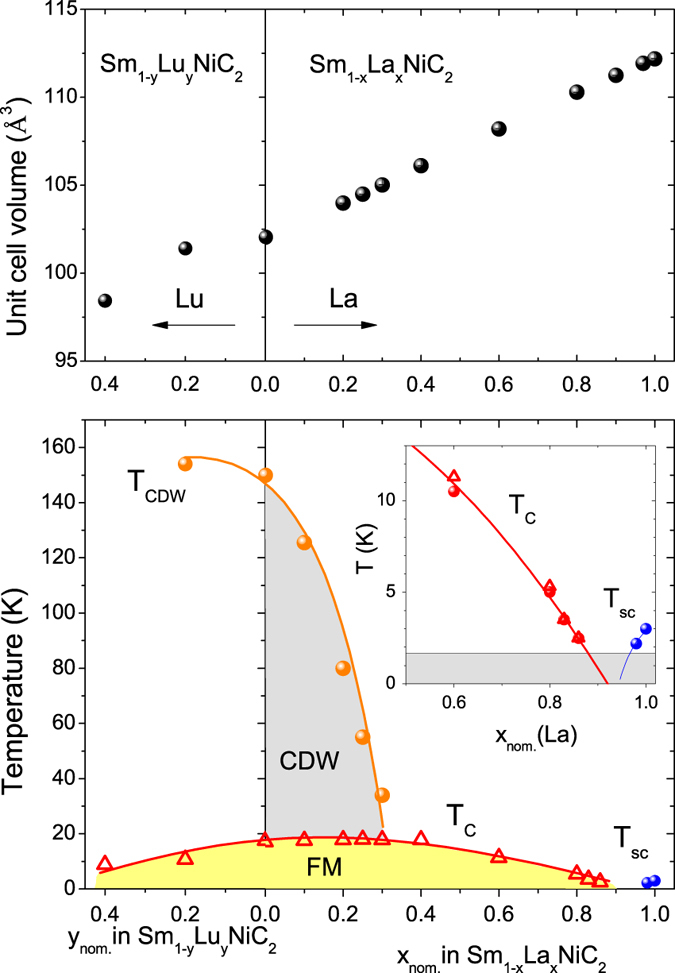
Temperature vs concentration phase diagram.Top panel shows the change in volume of the orthorhombic series Sm1−xLaxNiC2 (0 ≤ x ≤ 1) and Sm1−yLuyNiC2 (0 ≤ y ≤ 0.4) with respect to composition. The bottom panel shows the phase diagram of temperature vs. composition. For Sm1−xLaxNiC2, the CDW ordering disappears above x = 0.3, while the ferromagnetic phase survives up to x = 0.86. The superconductivity is rapidly suppressed for x < 1 in Sm1−xLaxNiC2. For the Lu-doped Sm1−yLuyNiC2, TCDW disappears for y > 0.2 and the magnetic phase decreases with increasing Lu concentration y. The open triangles are data points obtained from the magnetization measurements, while the solid circles are from resistivity measurements.